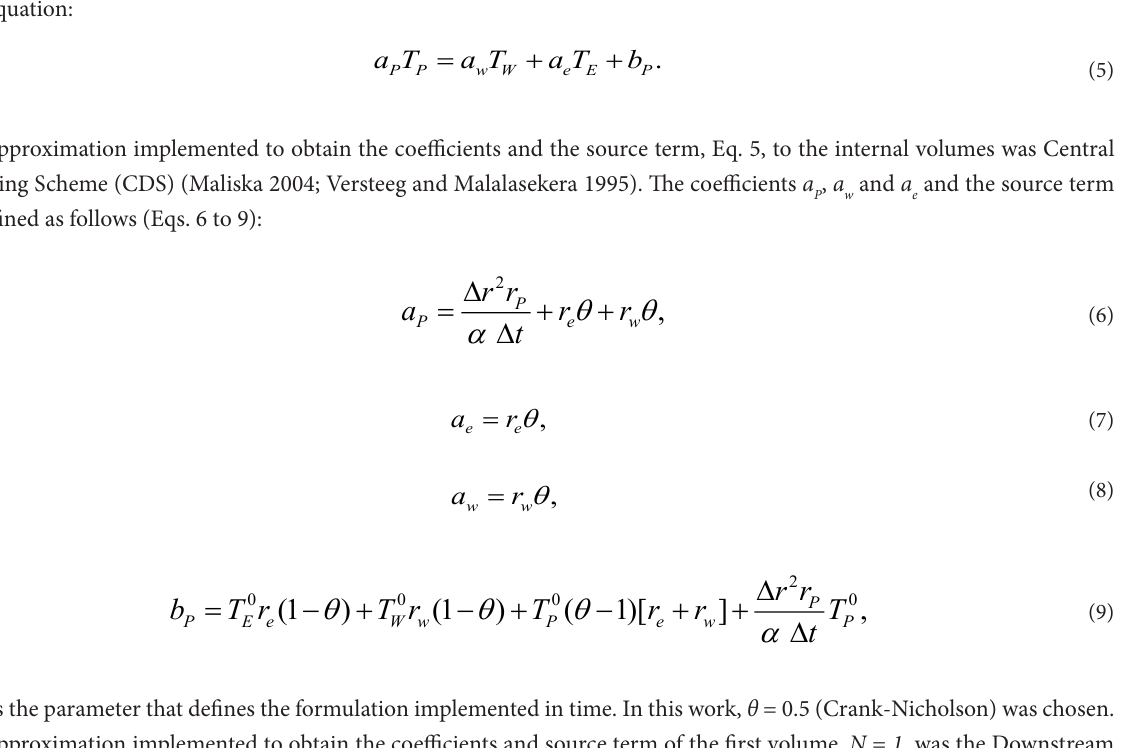
Figure 2. Uniform one-dimensional mesh.